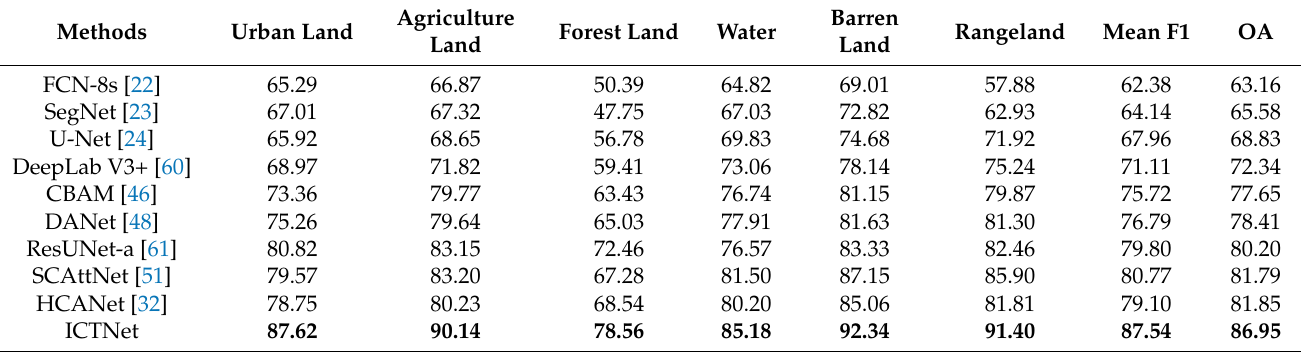
Table 4. Results of the DeepGlobe test set. The class-wise F1-score, mean F1-score, and OA are presented.